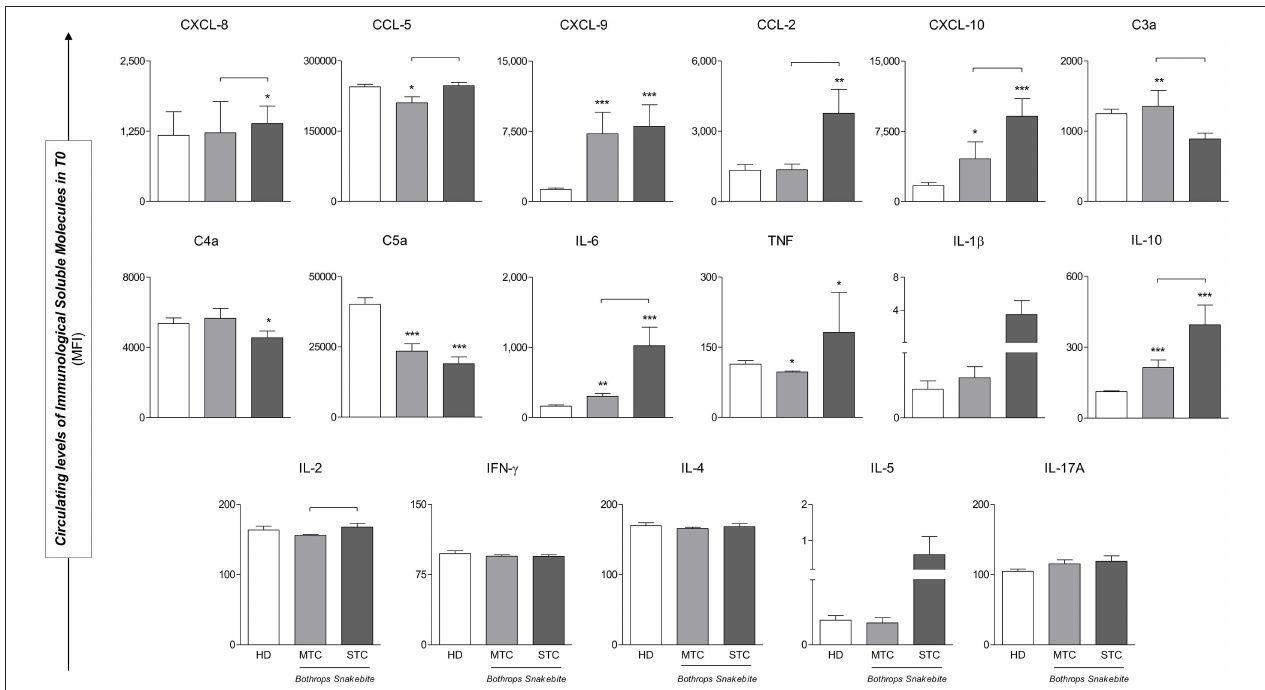
FIGURE 3 | STC Bothrops snakebite patients presented different circulating levels of immunological soluble molecules when compared to those with MTC and those of the HD groups in baseline (T0). Significant difference from the HD group * p < 0.05; ** p < 0.01; *** p < 0.0001; Statistical difference between MTC and STC groups, p < 0.05 was considered significant ( ). Immunological Soluble Molecules Level Quantification by CBA and ELISA. Data are expressed as mean ± standard deviation in Mean Fluorescence Intensity (MFI) for Immunological Soluble Molecules. Statistical analyses were performed by the Kruskal-Wallis test, followed by Dunn’s test in order to compare